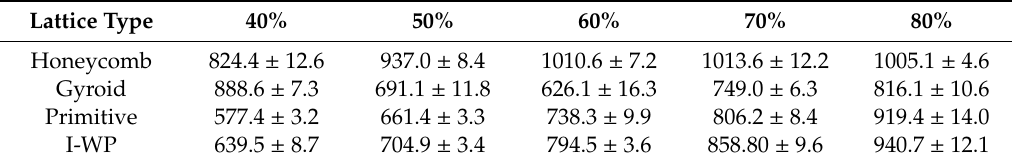
Figure 9. Histograms of ( a ) the tensile strength and ( b ) elongation percentage of the BCC, BCCZ, and honeycomb metal lattice test specimens with various relative densities. The x-axis denotes relative density: 40–80%, respectively. The blue bars represent BCC, the red denotes BCCZ, and the orange denotes honeycomb. Table 5. Summary of the tensile strength ( σ b / MPa) of the honeycomb, gyroid, primitive, and I-WP porous tensile test specimens under di ff erent relative densities